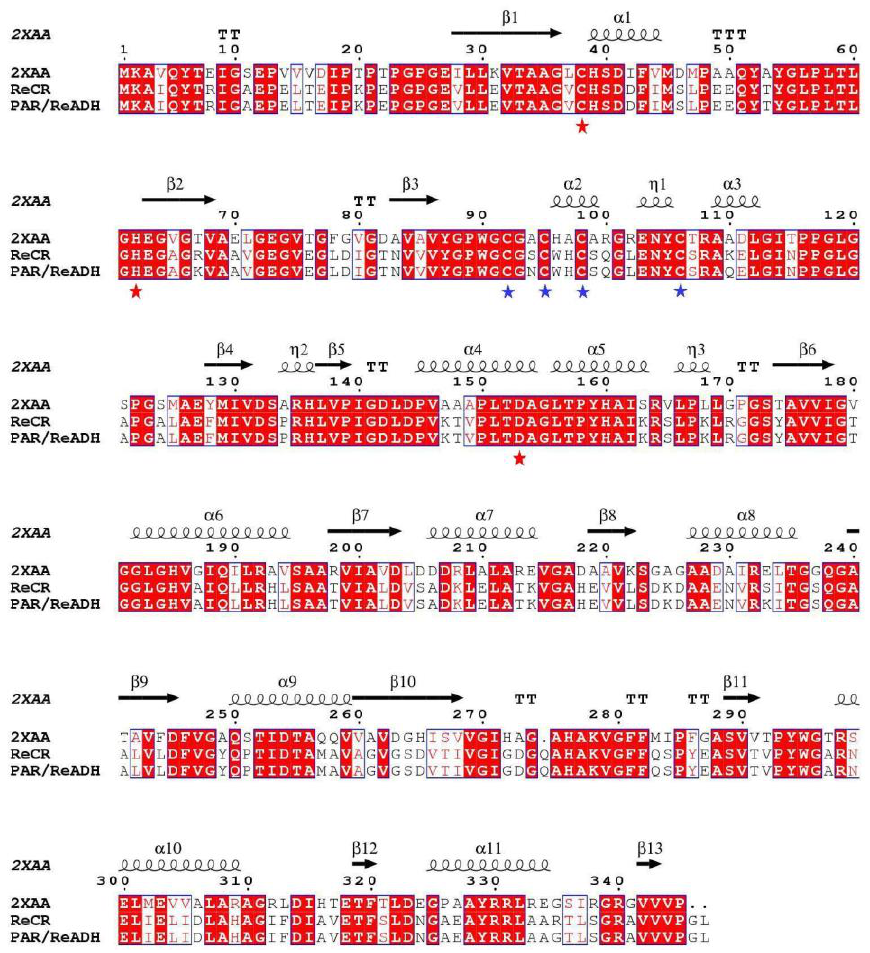
Figure 2. Structure-related sequence alignment between ReCR and its homologous proteins. 2XAA, PDB code of alcohol dehydrogenase from Rhodococcus ruber DSM 44541; PAR, alcohol dehydrogenase from Rhodococcus sp. ST-10 (GenBank accession No.: AB020760.3); ReADH, alcohol dehydrogenase from R. erythropolis DSM 43297 (GenBank accession No.: AY161280.1). The amino acid sequences of both PAR and ReADH are identical. Shown above the alignments are elements of the secondary structure of 2XAA. The numbering shown is from 2XAA. Red stars, putative catalytic residues; blue stars, residues for the coordination of structural zinc. Strictly conserved residues are highlighted with red boxes.